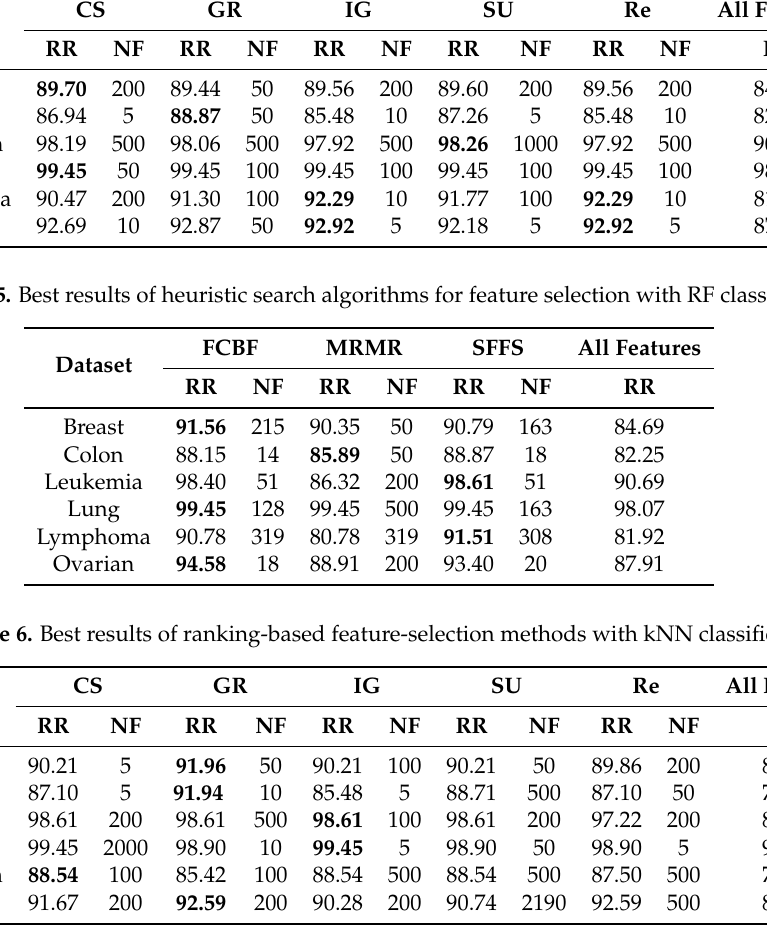
Table 4. Best results of ranking-based feature-selection methods with RF classifier. Dataset